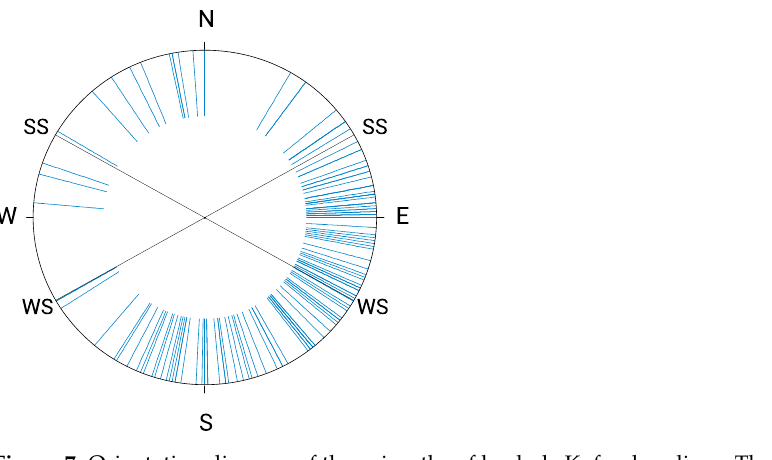
Figure 6. Kernel distribution of the azimuths of keyhole Kofun baselines. The azimuths of the Sun rising/setting at the summer (black lines)/winter (red lines) solstice (SS, WS) are reported.